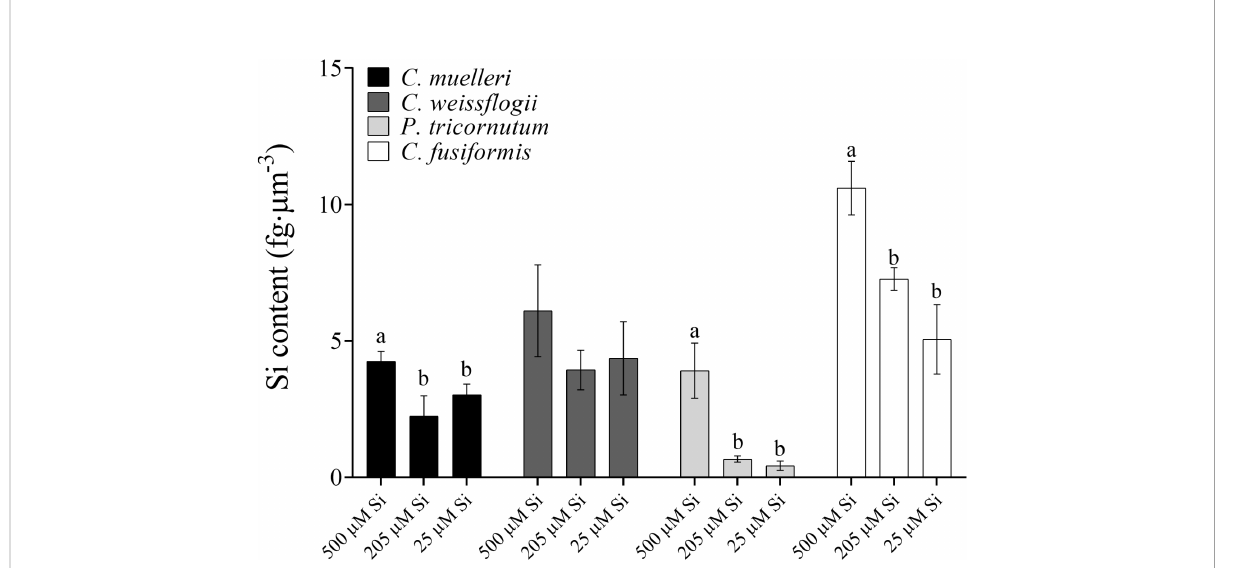
FIGURE 1 Si content per volume (fg·µm -3 ) in the four diatoms acclimated to different paleoenvironments. Data are means of three biological replicas. Error bars show SD. Different letters represent signi fi cant differences among conditions in the same species (p < 0.05, one-way ANOVA followed by Tukey ’ s post-hoc test, results in Table